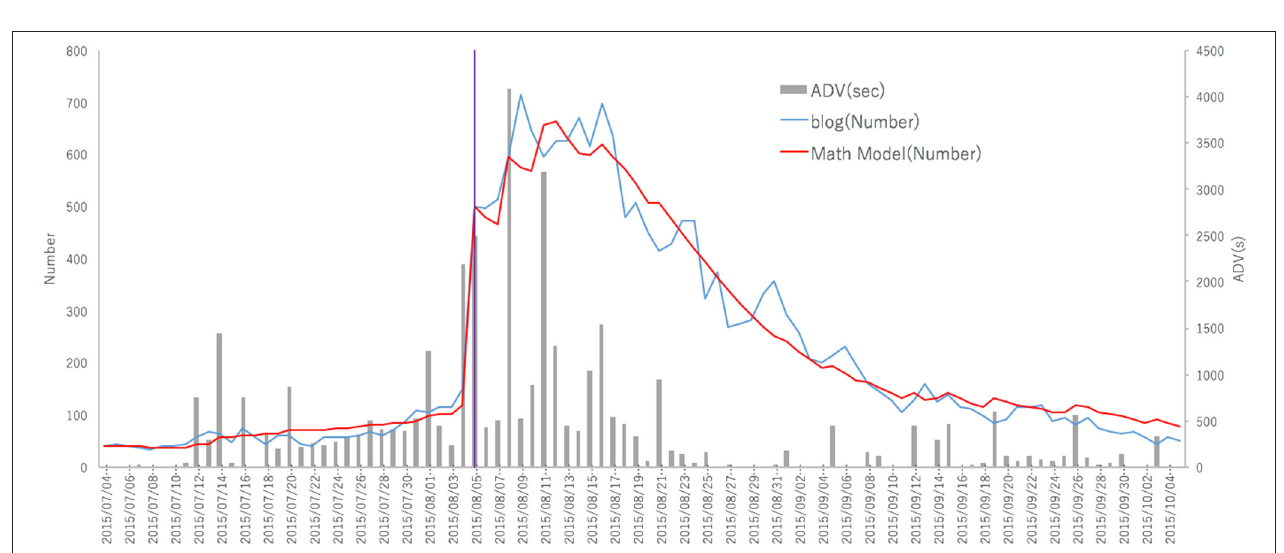
FIGURE 2 | Calculated and observed data for the movie, “Case B” in Japan. The histogram indicates [ADV (s)] is the number of daily exposures on TV information about “Case B” in seconds. The blue curve corresponds to the observed number of daily Twitter postings and the red curve is our calculation.